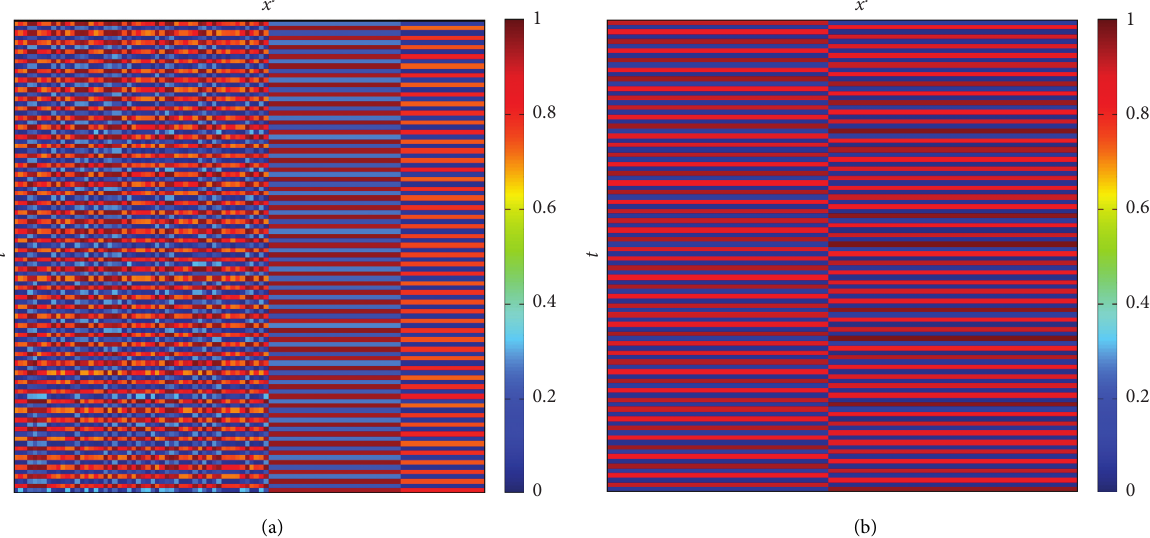
Figure 5: Asymptotic states x i (horizontal axis) as a function of time (vertical axis) for system equation (7) with size N � 100 and local map equation (11), for different values of parameters. Initial conditions and ordering of the maps are similar to those in Figure 2. Color code: two elements i,j share the same color if x i t � x j t . (a) Chimera state with two clusters, r � 3, ε � 0 . 235. (b) Two-cluster state, r � 3, ε � 0 . 272.